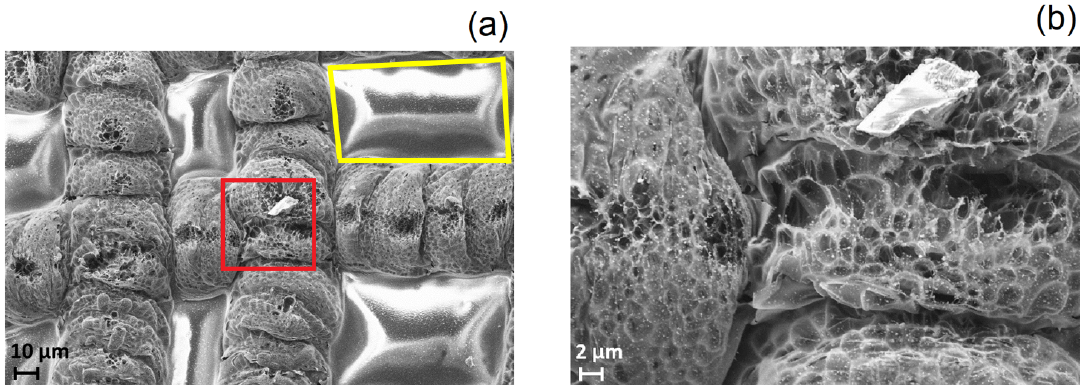
Figure 3. ( a ) SEM image of Kapton R (cid:13) polyimide (scale: 10 µ m, extraction and acceleration voltage: 5 kV, working distance: 6.0 mm) ablated using a laser power of 100 mW. The bright areas (such as the one framed in yellow) correspond to the non-irradiated surfaces; ( b ) SEM image (scale: 2 µ m, extraction and acceleration voltage: 5 kV, working distance: 6.0 mm) of the red framed area in ( a ) where the porous structure, resulting from the laser ablation process, can be